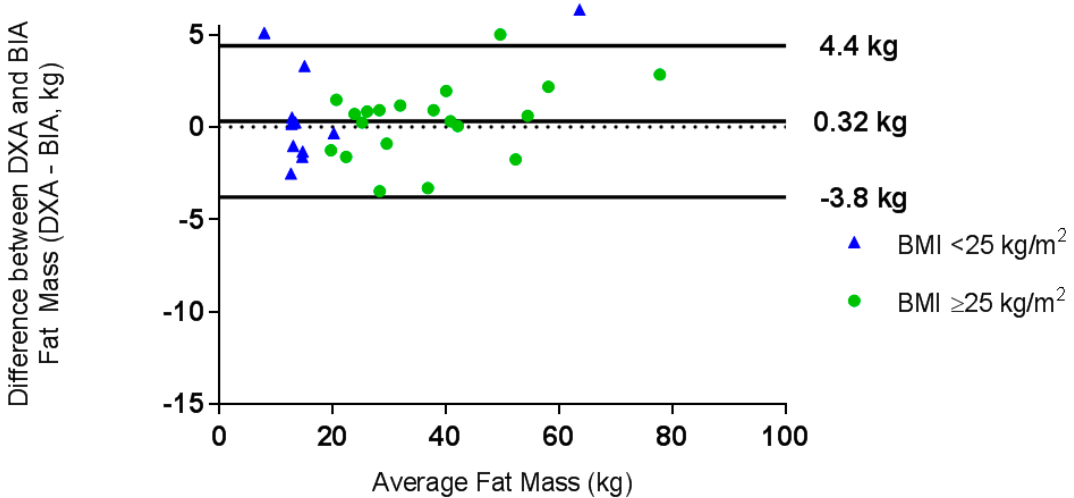
Figure 1. Bland-Altman plot of the difference between fat mass, as measured by dual energy X-ray absorptiometry (DXA) and bioelectrical impedance (BIA), against the mean fat mass (kg) for the whole group. ● BMI ≥ 25kg/m 2 , BMI < 25kg/m 2 .